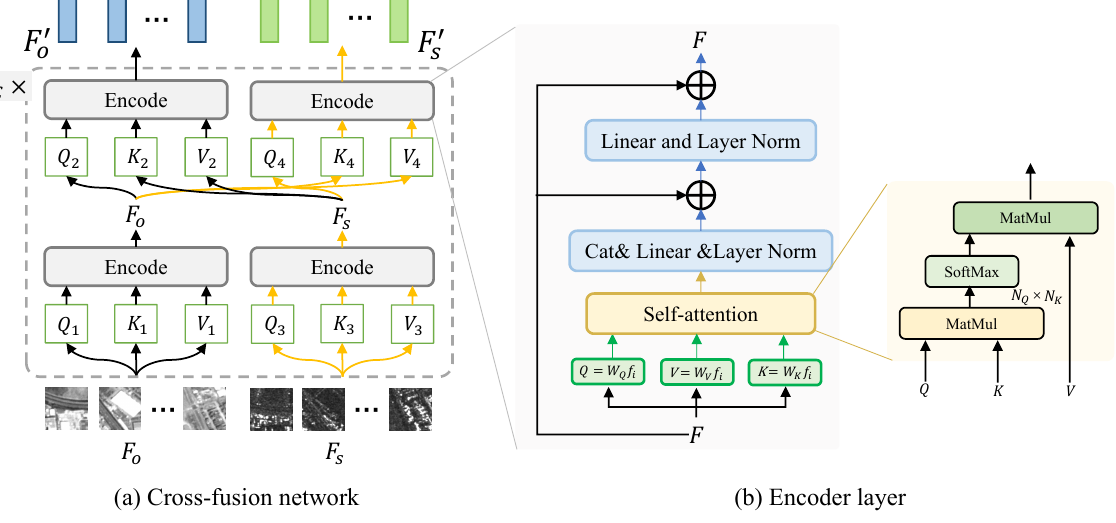
Figure 4. ( a ) Cross-fusion matching network architecture. N C denotes the number of times the network structure is executed. ( b ) Encode